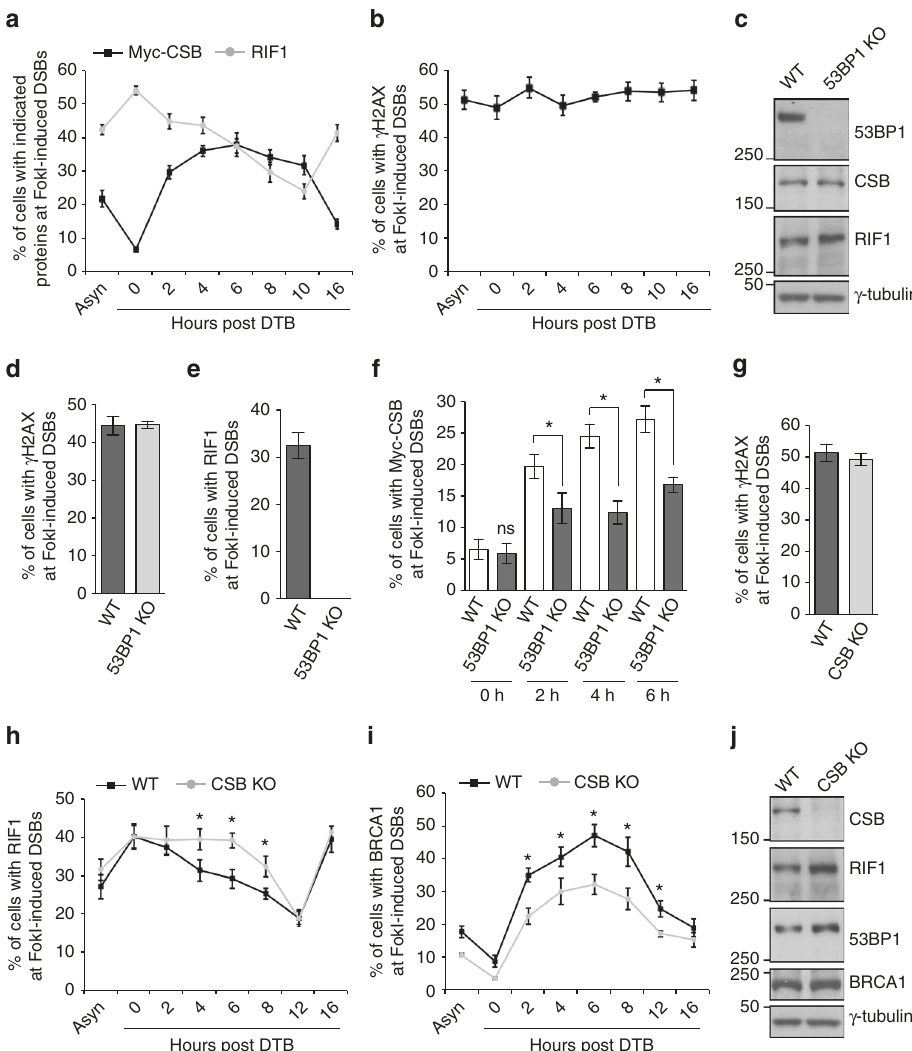
Fig. 4 CSB is recruited to FokI-induced DSBs in S phase to inhibit RIF1. a Quanti fi cation of the percentage of synchronized Myc-CSB-expressing U2OS-265 cells exhibiting indicated proteins at FokI-induced DSBs. For Myc-CSB, a total of 250 Myc-CSB-expressing cells were scored for each independent experiment in blind. For RIF1, a total of 500 – 550 cells were scored in blind for each independent experiment. SDs from three independent experiments are indicated. b Quanti fi cation of the percentage of synchronized Myc-CSB-expressing U2OS-265 cells exhibiting γ H2AX at FokI-induced DSBs. A total of 500 – 550 cells were scored in blind for each independent experiment. SDs from three independent experiments are indicated. c Western analysis of U2OS- 265 parental (WT) and 53BP1 KO cells. The γ -tubulin blot was used as a loading control here and the following fi gures. d Quanti fi cation of the percentage of U2OS-265 WT and 53BP1 KO cells with γ H2AX at FokI-induced DSBs. Scoring was done as in 3b. SDs from three independent experiments are indicated. e Quanti fi cation of the percentage of U2OS-265 WT and 53BP1 KO cells with RIF1 at FokI-induced DSBs. Scoring was done as in Fig 3b. SDs from three independent experiments are indicated. f Quanti fi cation of the percentage of synchronized Myc-CSB-expressing WT and 53BP1 KO U2OS-265 cells with Myc-CSB at FokI-induced DSBs. A total of 250 Myc-CSB-expressing cells were scored for each independent experiment in blind. SDs from three independent experiments are indicated. * P < 0.05 (Student t test). g Quanti fi cation of the percentage of U2OS-265 WT and CSB-KO cells with γ H2AX at FokI-induced DSBs. Scoring was done as in Fig. 3b. SDs from three independent experiments are indicated. h Quanti fi cation of the percentage of synchronized U2OS-265 WT and CSB KO cells with RIF1 at FokI-induced DSBs. Scoring was done as in Fig. 3b. SDs from three independent experiments are indicated. * P < 0.05 (Student t test). i Quanti fi cation of the percentage of synchronized U2OS-265 WT and CSB KO cells with BRCA1 at FokI-induced DSBs. Scoring was done as in Fig. 3b. SDs from three independent experiments are indicated. * P < 0.05 (Student t test). j Western analysis of U2OS-265 WT and CSB KO